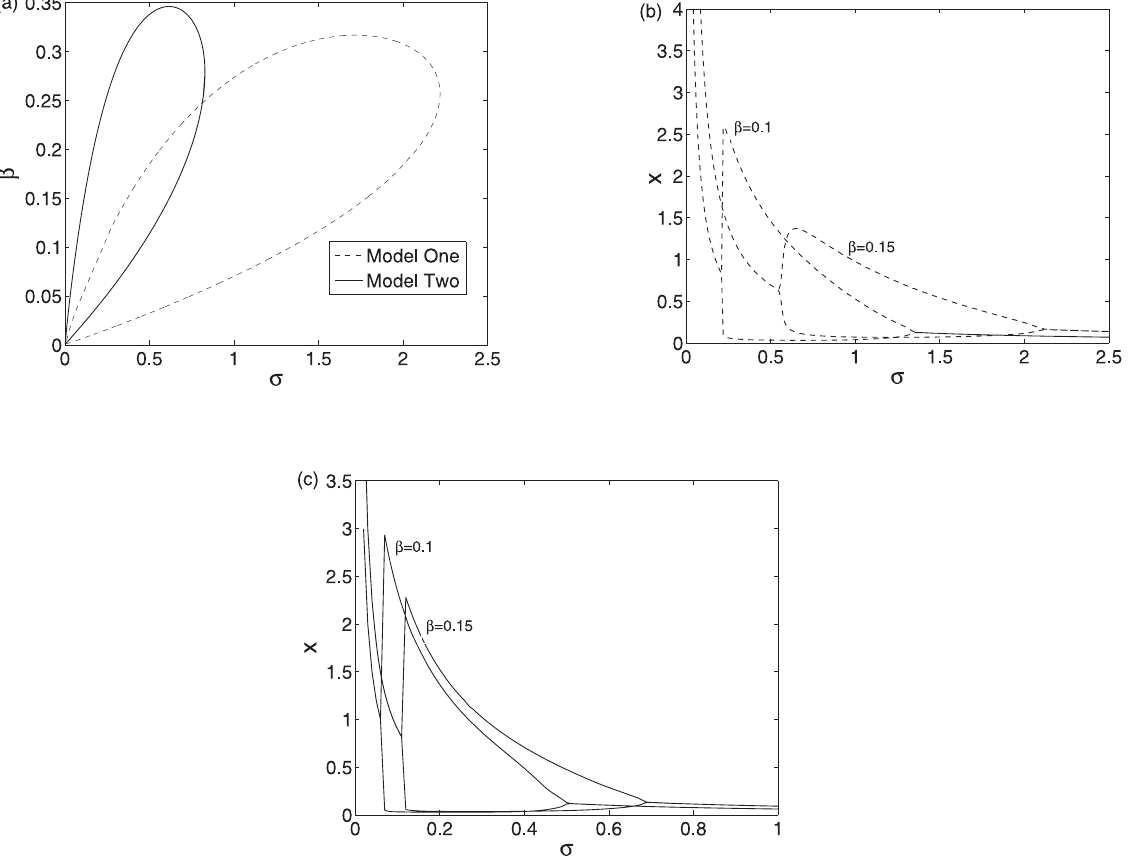
Figure 8. The bifurcation diagrams of the two models. (a) The oscillatory regions of the two systems. (b) The bifurcation diagrams of the first model. (c) The bifurcation diagrams of the second model. The parameter values are b ~ 0 : 2 , l ~ 0 : 3 , c ~ 5 , a ~ 2 , r ~ 100 , m ~ 2 , and d ~ 0 : 5 .